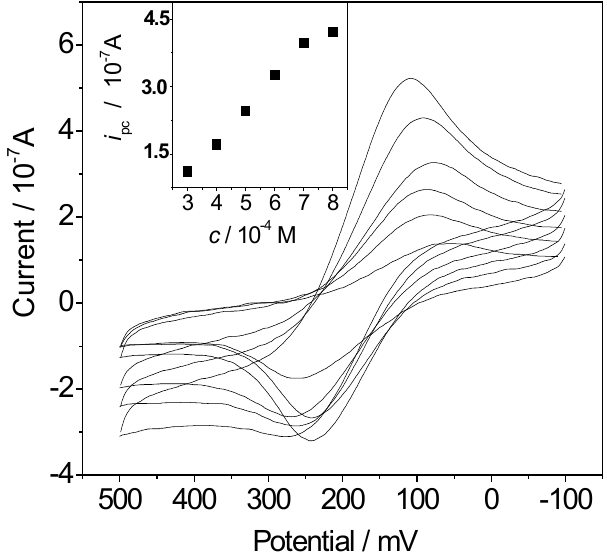
Figure 4. Cyclic voltammograms of 0.3, 0.4, 0.5, 0.6, 0.7 and 0.8 mM FcPF to external) at ssDNA/SAM/Au at 200 mV s -1 . Inset: plot of i